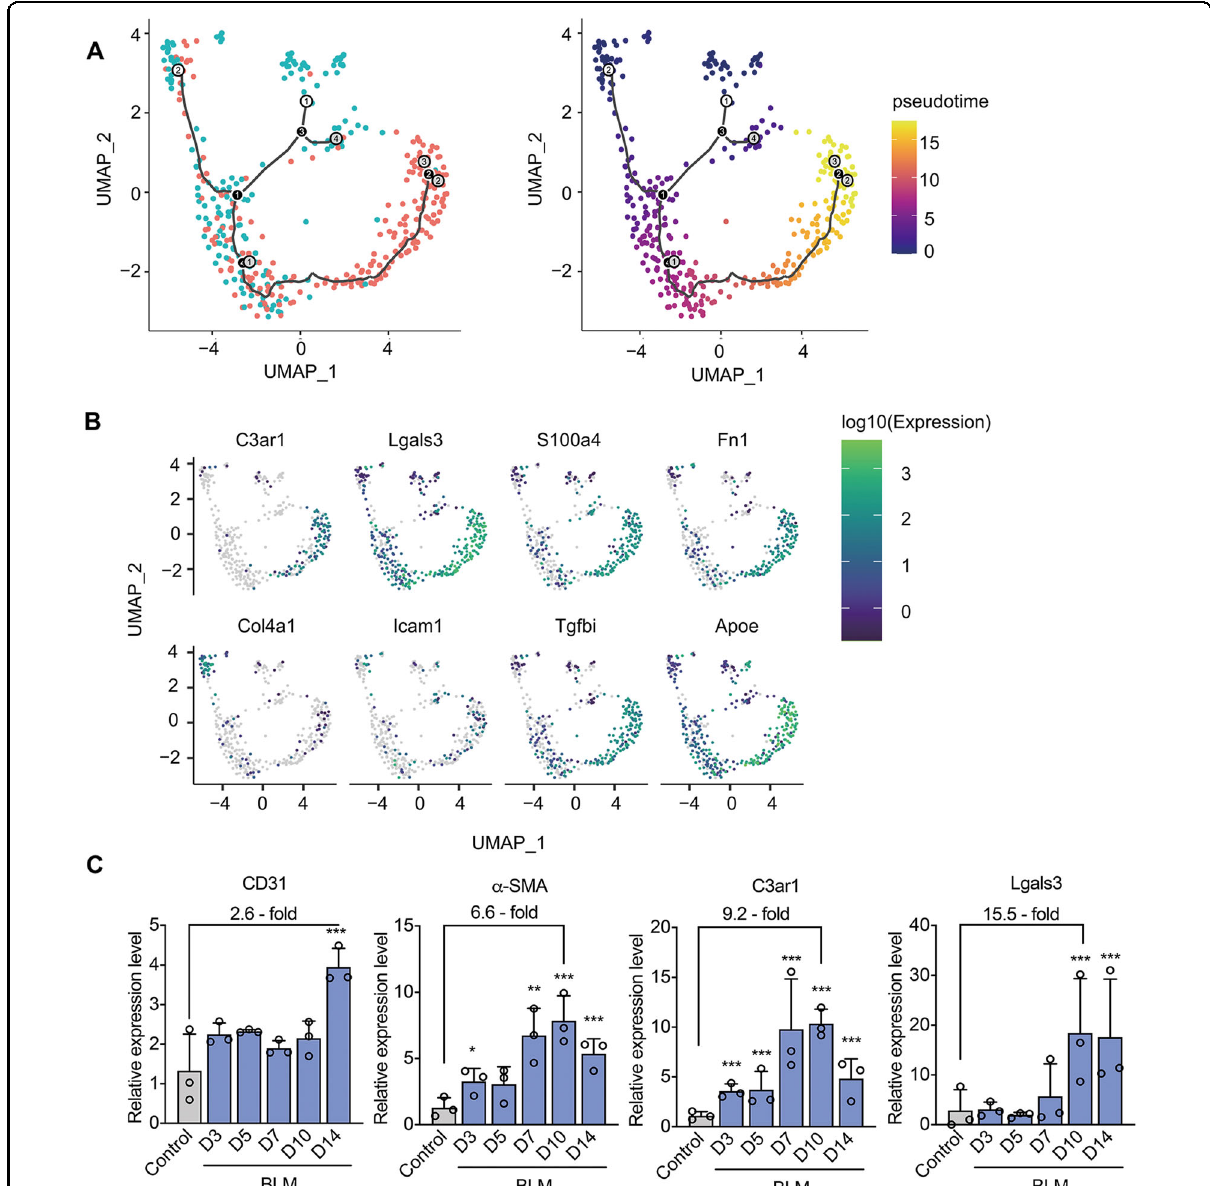
Fig. 3 Pseudotemporal trajectory analysis of ECs revealing factors related to the EndMT process. A Merged pseudotime analysis of both groups revealing the transitional trajectory of ECs using Monocle3. Hollow circles: start/end nodes; black circles: branching nodes; black curve: pseudotemporal trajectory. B Expression of genes highly correlated with the pseudotemporal trajectory representing the EndMT process. C3ar1 complementary component 3a receptor 1, Lgals3 galectin-3, S100A4 S100 calcium binding protein A4, Fn1 fi bronectin 1, Icam-1 intercellular adhesion molecule-1, Col4a1 collagen type IV alpha 1 chain, Tgfbi transforming growth factor beta induced, Hif1a hypoxia inducible factor 1 subunit alpha. C Expression levels of candidate regulators in whole-lung samples from the BLM and control groups according to RT-PCR. CD31: platelet and endothelial cell adhesion molecule 1, α -SMA: actin, alpha 2, smooth muscle, aorta. The data presented as the means ± SD, n = 3. * p < 0.05, ** p < 0.01, *** p <